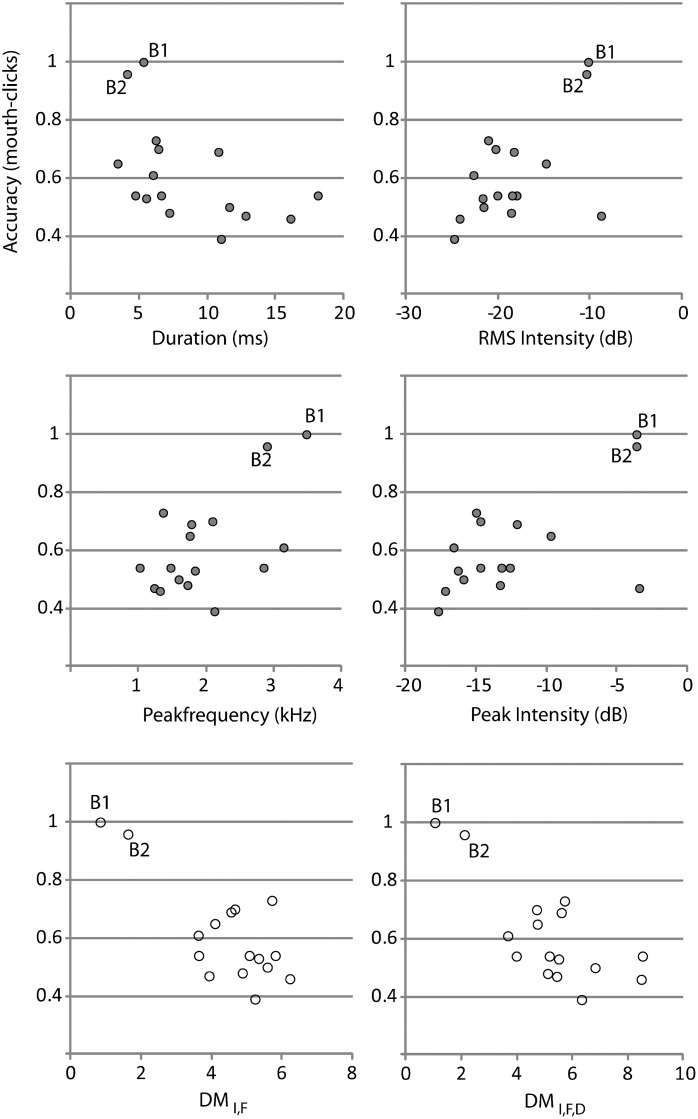
Scatterplots between individual acoustic variables and performance.Data from B1 and B2 are highlighted in the plots.